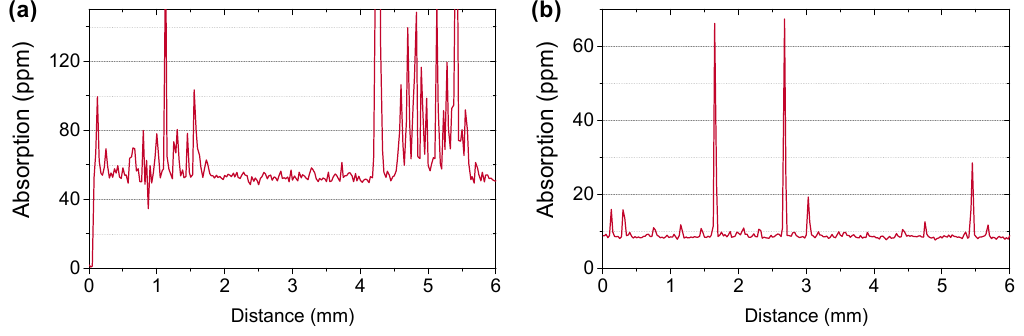
Figure 4. PCI absorption x ‐ scan of the ( a ) ZrO 2 / SiN; ( b ) ZrO 2 / SiO 2 coating samples.